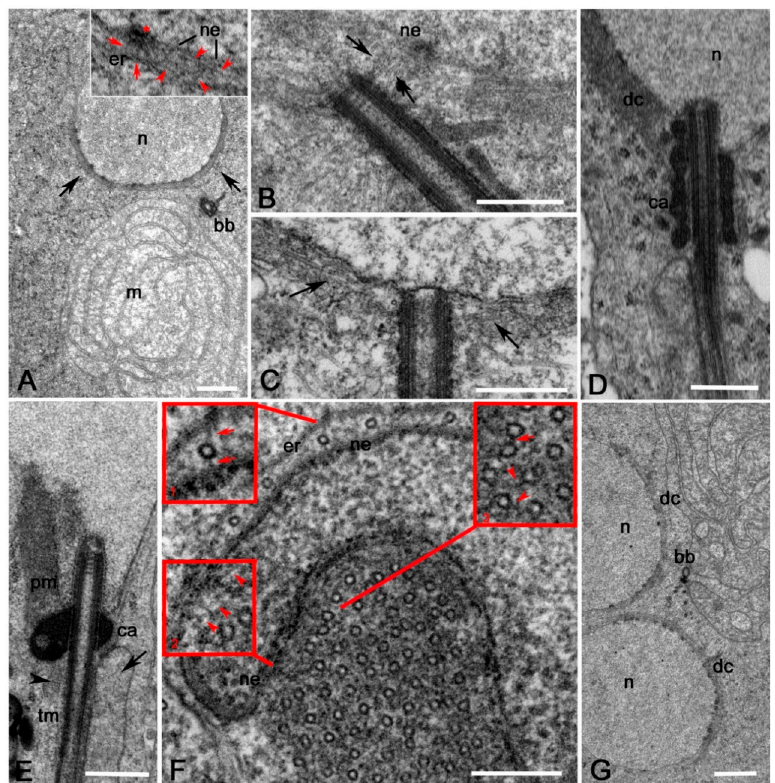
Figure 7. Ultrastructure of early spermiogenesis from dissected pupal testes. ( A ) Onion stage spermatid: m, mitochondria; bb, basal body; n, nucleus; arrows, dense complex. The inset shows detail of the dense complex in which thin filaments (6–7 nm thick) are present running parallel (red arrowheads) to the nuclear envelope (ne) and microfilaments (red arrows) that link nuclear pores (asterisk) to the endoplasmic reticulum (er) that surrounds the basal region of the nucleus. ( B ) Young onion stage spermatid showing that some MTs (arrows) emerging from the basal region of a disoriented basal body contact the nuclear envelope (ne). ( C ) When the basal body docks to the nuclear envelope, most of the MTs emerging from its basal region (arrows) run parallel to the nucleus. ( D ) Detail of a leaf stage spermatid: the pericentriolar material increased to form the centriole adjunct (ca) and the dense complex (dc) moved on the lateral side of the nucleus ( n ). ( E ) Detail of an early canoe stage spermatid in which the basal body is partially enclosed within a nuclear pocket. The centriole adjunct (ca) compacts in a dense cluster that is the anchoring site for the major (arrow) and minor (arrowhead) mitochondrial derivatives, while perinuclear (pm) and tail (tm) MTs originate in opposite direction from the centriole adjunct. ( F ) Cross-section of a canoe stage nucleus ( n ): isolated MTs run along the convex side of the nucleus and some of them show links (red arrows, Inset 1) between the nuclear envelope (ne) and the endoplasmic reticulum (er). Thin filaments (red arrowheads, Inset 2) are visible on the concave side of the nucleus close to the nuclear envelope: the concave side of the nucleus is filled by longitudinal MTs that are often linked together by lateral bridges (red arrow, Inset 3) or show bridges that end within the material (red arrowheads, Inset 3) that form the dense complex. ( G ) Cog7 mutant spermatid at the onion stage showing two nuclei ( n ) and one basal body (bb): both the nuclei display distinct dense complexes (dc). Scale bars: ( A – C, G ), 1 µ m; ( D, E ), 0.5 µ m; ( F ), 0.1 µ